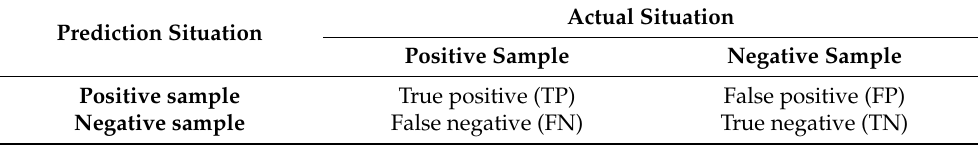
Table 3. Confusion matrix of prediction results.